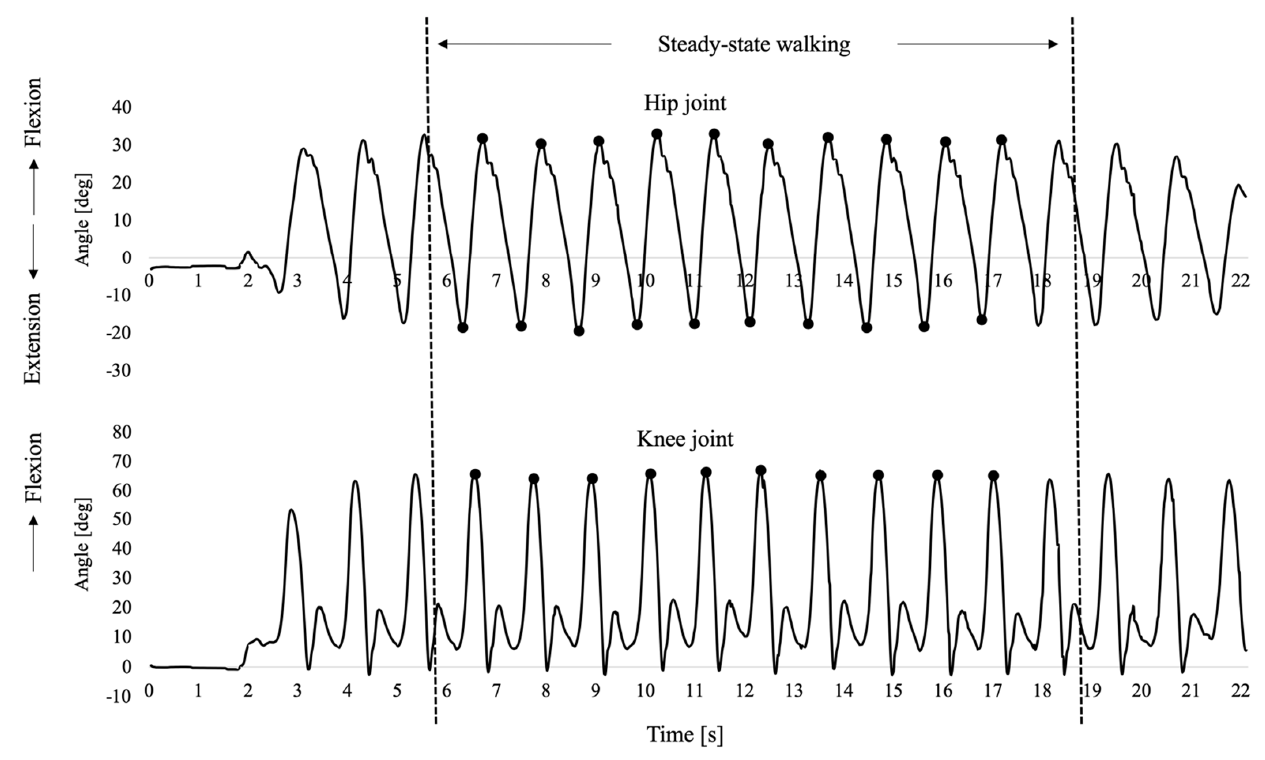
Figure 4. Example of time series data of the hip and knee flexion angles in one trial. The peak flexion angles of the hip and knee joints in the swing phase and the peak extension angle of the hip were extracted in 10 gait cycles. The hip excursion was calculated from the amplitude of the displacement between the extension and flexion angles.